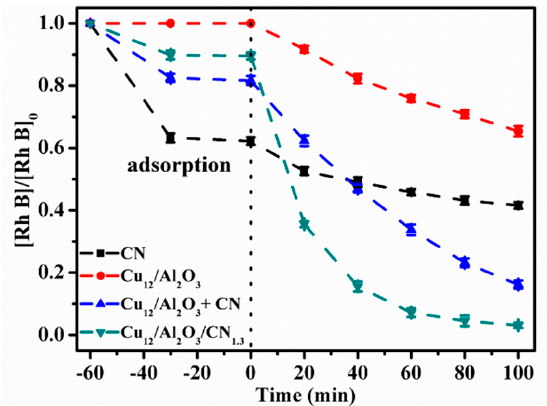
Figure 8. [Rh B] / [Rh B] 0 as a function of time in the presence of 1 g / L di ff erent samples. Reaction Figure 8. [Rh B]/[Rh B] 0 as a function of time in the presence of 1 g/L different samples. Reaction conditions: [Rh B] 0 = 20 mg / L, [H 2 O 2 ] 0 = 10 mM, V = 100 mL, T = 25 ◦ C, pH 4.9 conditions: [Rh B] 0 = 20 mg/L, [H 2 O 2 ] 0 = 10 mM, V = 100 mL, T = 25 °C, pH 4.9 (unadjusted).